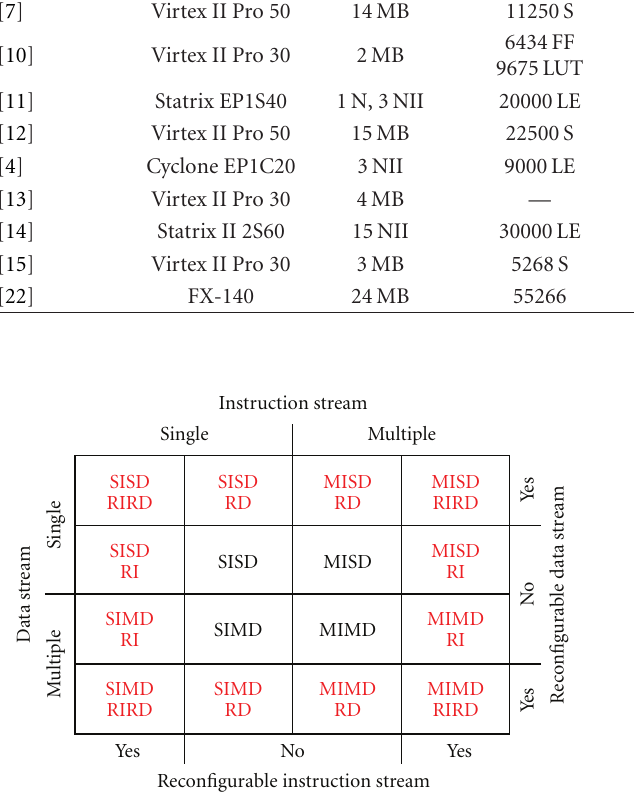
Figure 8: New taxonomy for reconfigurable FPGA-based systems proposed by G¨ohringer et al. [29]